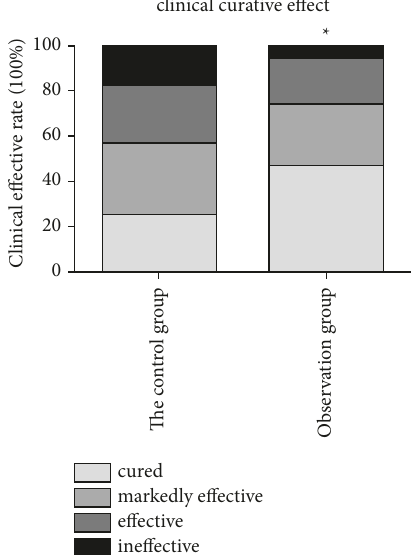
Figure 1: Comparison of clinical efficacy between the control group and the observation group. Note. Compared with the control